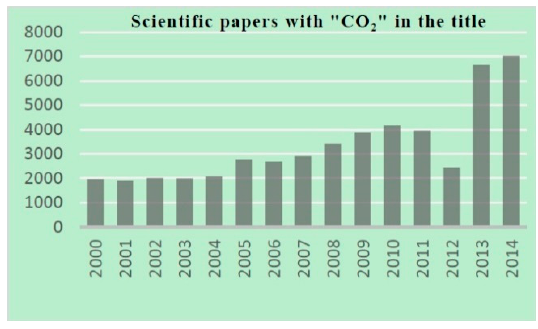
Figure 1. Scopus ® (Elsevier) scientific document analysis.